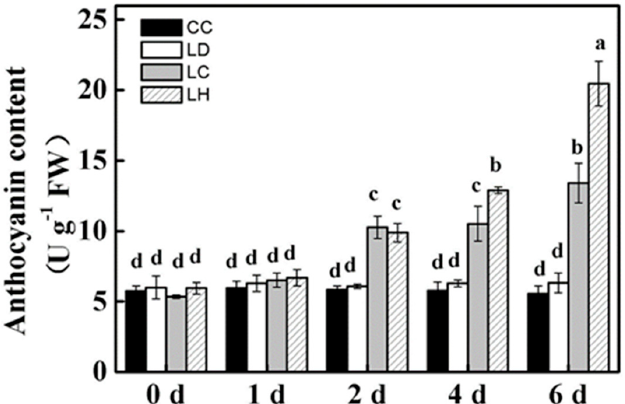
Figure 7. Changes in anthocyanin contents in the leaves of B. semperflorens growing under CC (25 °C/15 °C, 300 µmol m –2 s –1 ), LD (15 °C/5 °C, 100 µmol m –2 s –1 ), LC (15 °C/5 °C, 300 µmol m –2 s –1 ), and LH (15 °C/5 °C, 500 µmol m –2 s –1 ) conditions. The values represent the means ± SD ( stand deviatio ) of three replicates. Means denoted by the same letter (a, b, c, d) did not significantly differ at p < 0.05 according to Tukey’s test. FW: fresh